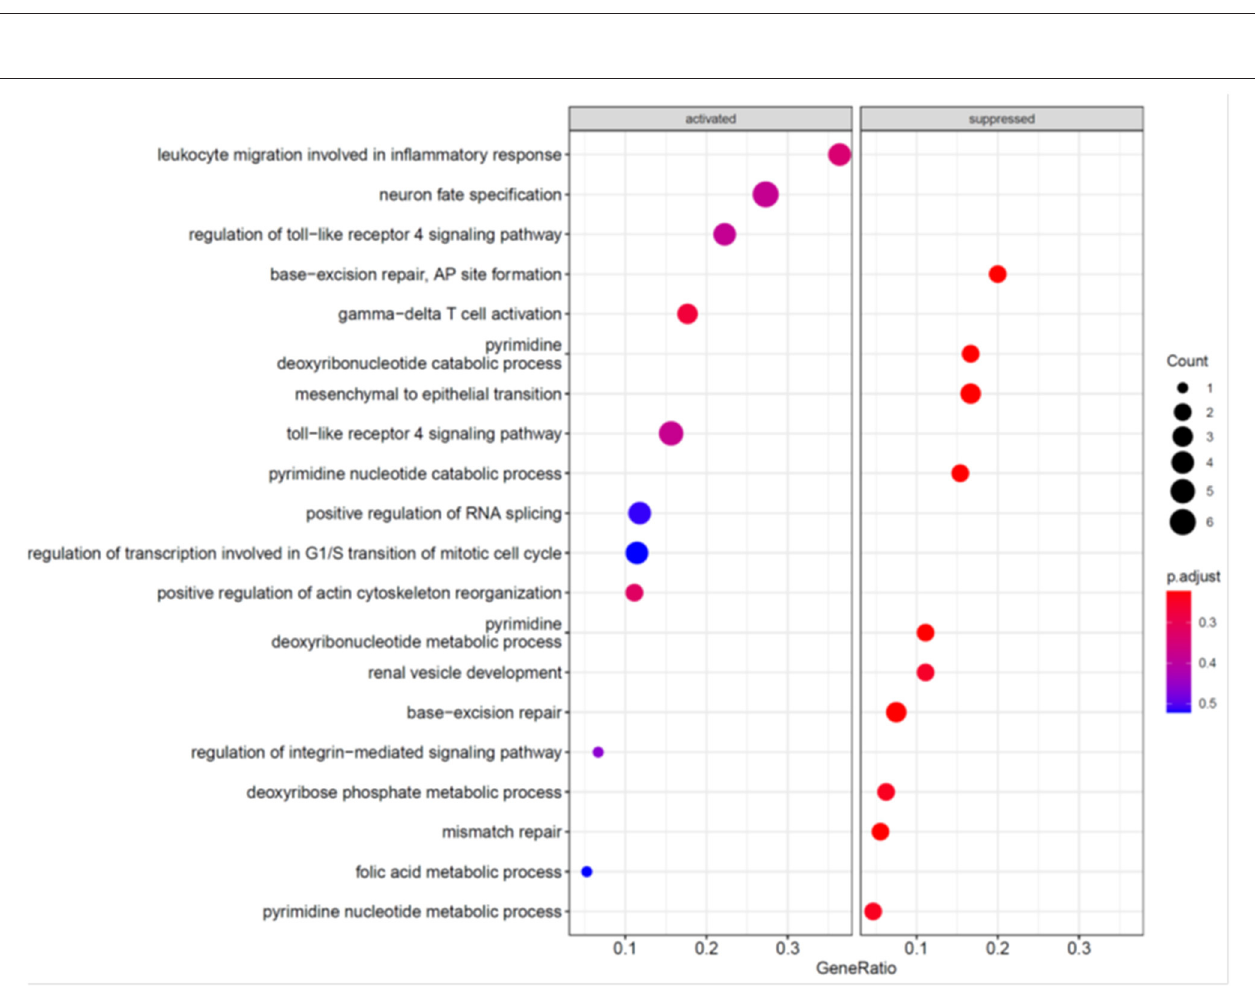
FIGURE 7 | GO_BP analyses of genes regulated in the podocytes deficient in MCC.